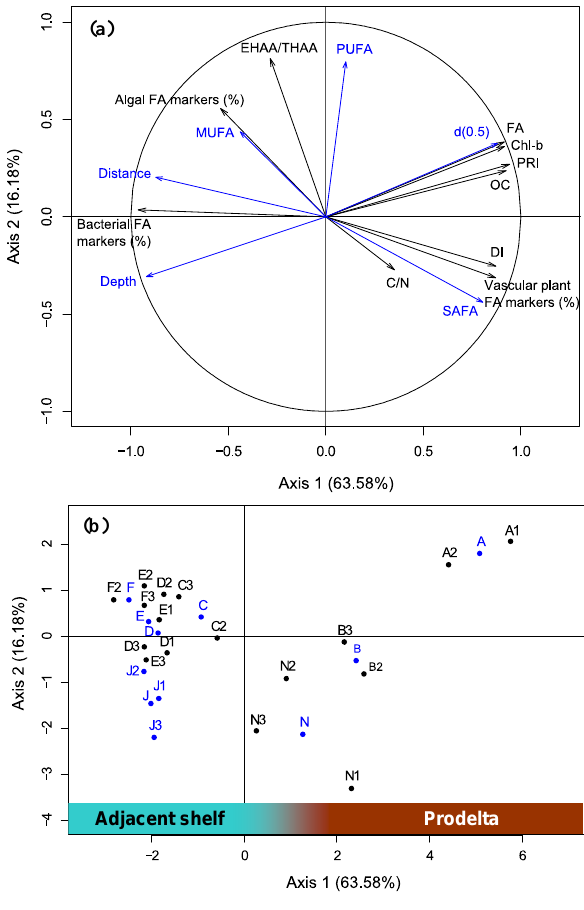
Fig. 6. Plot of loadings (a) and scores (b) for PCA of bulk and molecular-level characteristics of the OM from 7 stations located along a southwestward transect off the Rhˆone River and a marine reference site (station J). PCA was based on total fatty acid content (FA), vascular plant FA markers, bacterial FA markers, algal FA markers, pigment ratio index (PRI), organic carbon (OC), C/N ratio, chlorophyll- b (Chl- b) , degradation index (DI) and EHAA/THAA ratio (in black). Other scores (average for each station and the marine reference) and loadings (distance, depth, d (0.5), %SAFA, %MUFA, %PUFA) were introduced as supplementary parameters (in